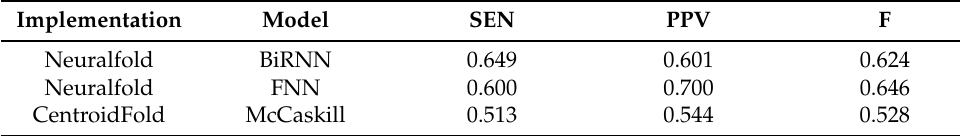
Table 1. Accuracy of inferred base-pairing probabilities for TestSetB.